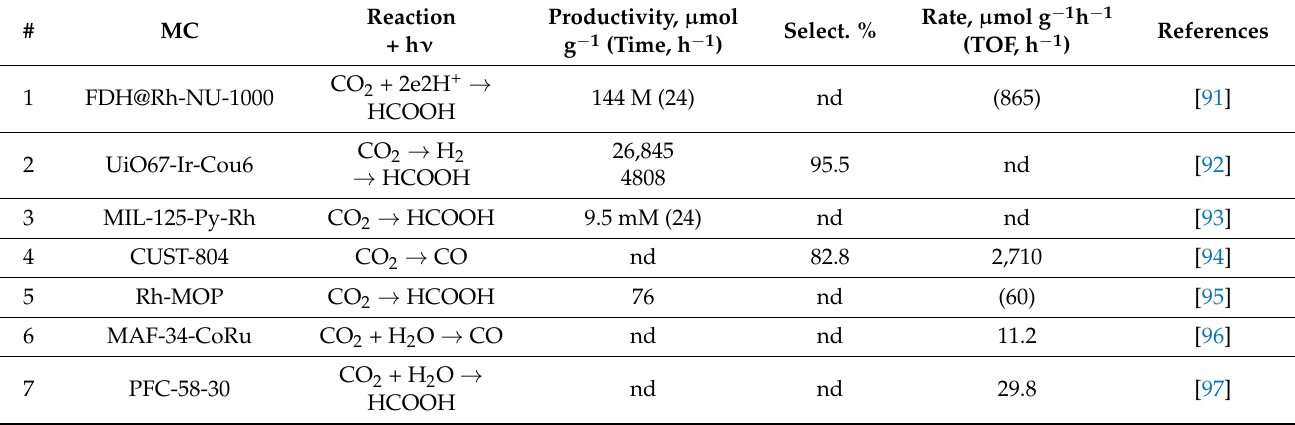
Table 1. Photosynthesis mimics.